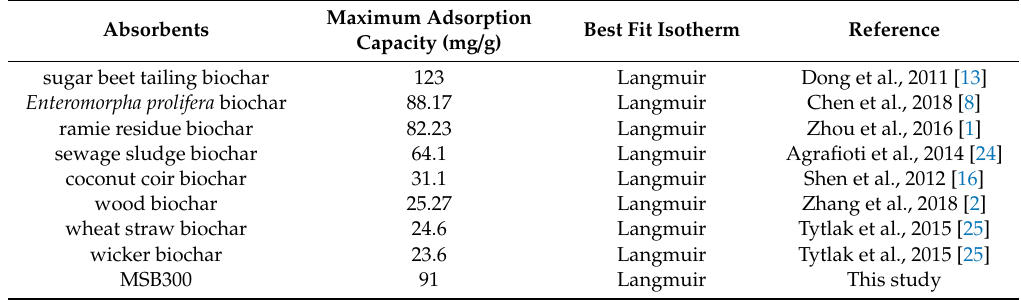
Table 3. Comparison of the maximum adsorption capacities of Cr(VI) on MSB300 with other